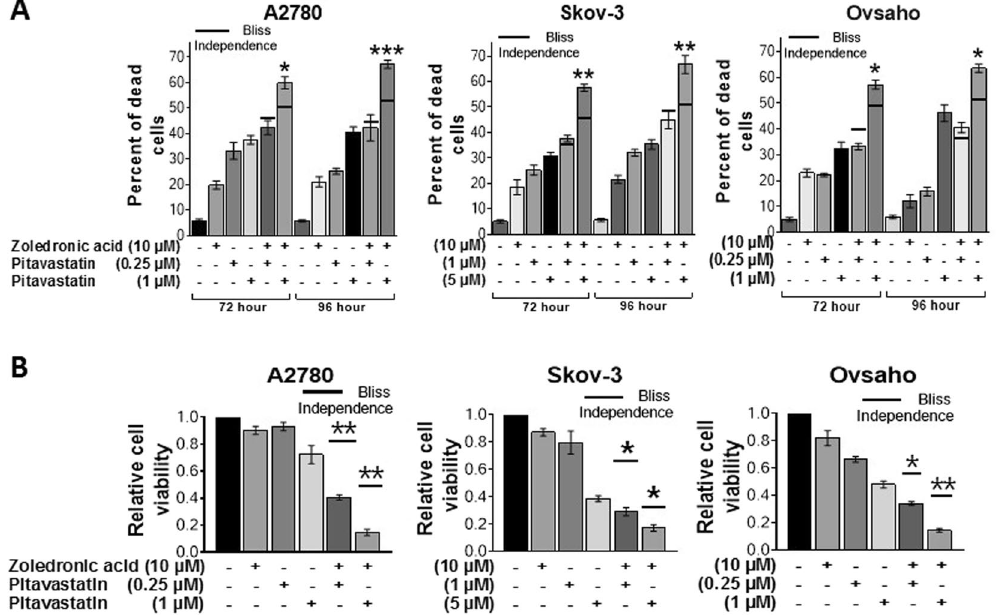
Figure 2. The effect of pitavastatin-zoledronic acid combinations on cell death. ( A ) Dead cells were measured by trypan blue staining after 72 and 96 hr of exposure to the indicated drug concentration. ( B ) Relative cell viability was measured by celltiter-Glo assay (ATP) after 72 hrs exposure to the indicated drug concentration. In both assays, the results (mean ± SD; n = 3) were compared to the effect expected for an additive interaction calculated using the Bliss independence criterion (solid line for each drug combination) and determined using the measured effect of the individual drugs in each individual experiment. Results were significantly different from the expected Bliss effect where shown ( * P < 0.05; ** < 0.01; *** < 0.001 , paired